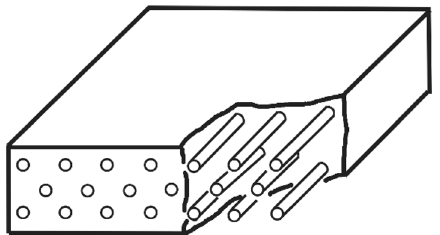
Figure 1. Schematic structure of the unidirectional SiC f /SiC minicomposite.